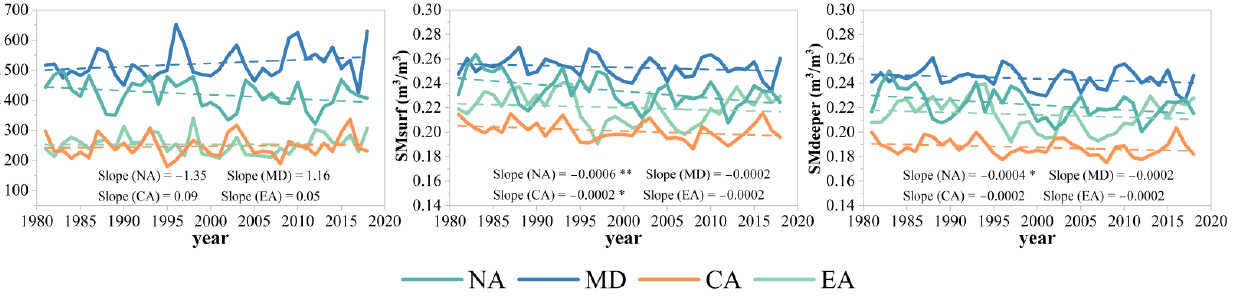
Figure 12. Temporal variation trends of precipitation, surface soil moisture and deeper soil moisture over four regions from 1981 to 2018 (*, p < 0.05; **, p < 0.01). Meanwhile, a partial correlation analysis was performed to evaluate the relationship between the 38-year average LAI and precipitation, surface soil moisture, and deeper soil moisture in the places where LAI increasing trends were greater than the regional average and LAI decreased significantly (Figure 7). As shown in Table 3, drylands where LAI decreased significantly (slope < 0 per year) exhibited positive correlations ( p < 0.001) between LAI and SMsurf and negative correlations ( p < 0.001) between LAI and SMdeeper in NA, MD, and EA. The correlations between LAI and PRE exhibited positive correlations ( p < 0.001) in NA, CA, and EA. However, drylands where LAI increasing trends were greater than the regional average (slope > 0.001 and 0.006 per year) exhibited positive correlations ( p < 0.001) between LAI and SMsurf in all four regions and negative correlations ( p < 0.001) between LAI and SMdeeper in NA, MD, and EA. The correlations between LAI and PRE were positive ( p < 0.001) in all four